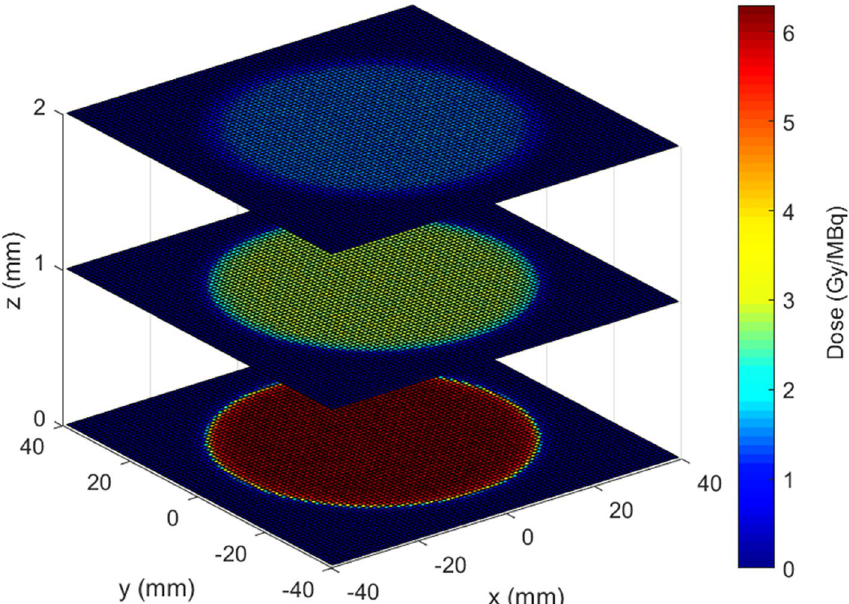
Figure 1. Orthogonal view of the dose distribution per unit of activity (Gy/MBq) on three parallel planes: the tumour bed (z = 0 mm) and at 1 and 2 mm distance. The values are obtained for circular tumour bed with R = 30 mm and for a BAT-90 thickness t = 0